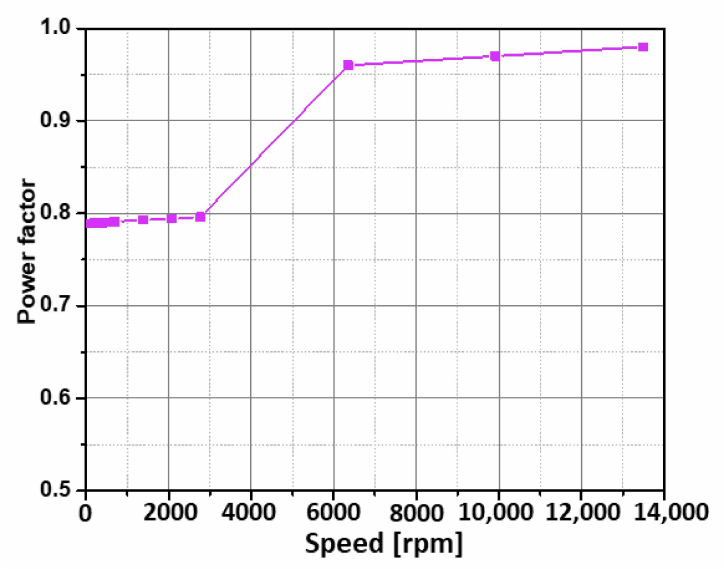
Figure 16. Power factor vs.